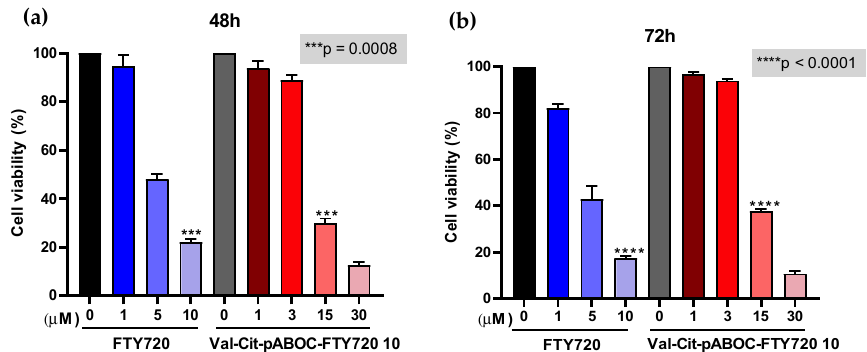
Figure 3. Cytotoxicity studies using PC3 cells incubated with different concentrations of FTY720 and Val-Cit-pABOC-FTY720 after ( a ) 48 h and ( b ) 72 h of treatment. Data are presented as average counts ± s.d. (n = 3) (unpaired t -tests performed using GraphPad Prism 9.4.1).